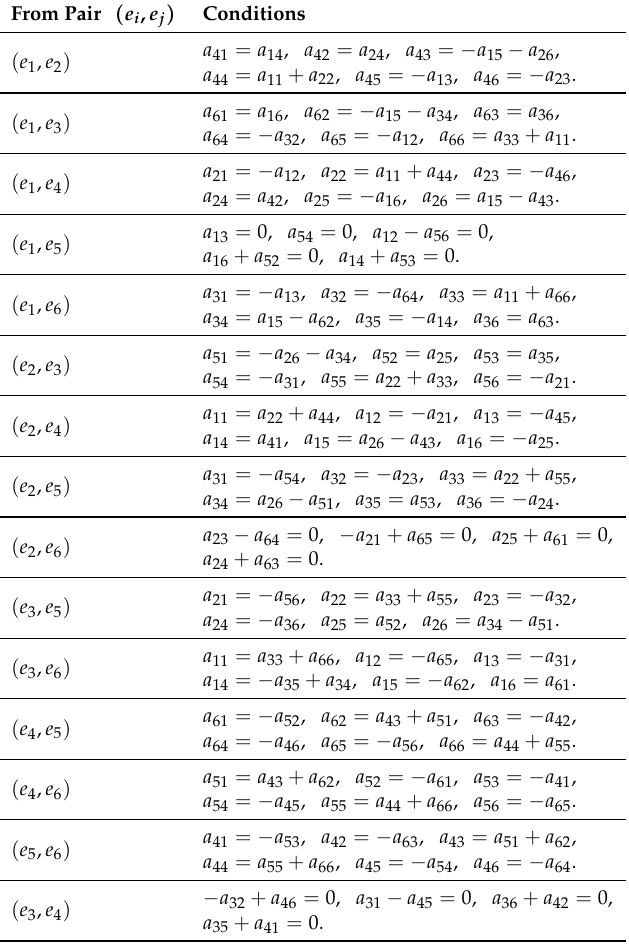
Table 1. Condition obtained.